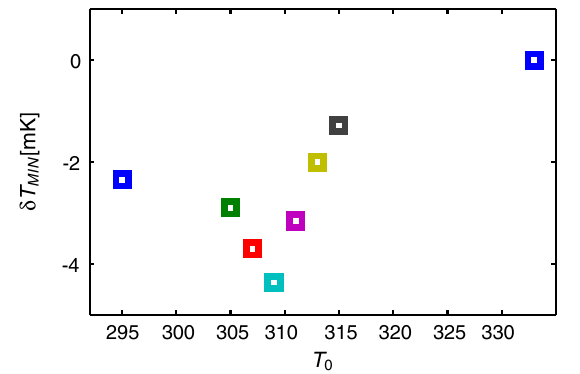
FIG. 10. The minima from Fig. 8 as a function of temperature. At high temperatures, the phenomenon of cooling by heating is absent. Going down in temperature, the liquid becomes more viscous and a dip in temperature emerges. Close to the glass in